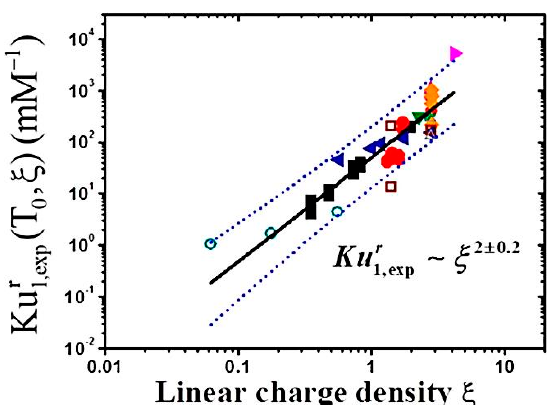
Figure 10. Experimentally reported binding strength data rescaled to SDS reference system as a function of polyelectrolyte reduced linear charge density. Solid black line is power-law regression and blue dotted line is 95% prediction interval. Points represent various studies. Reprinted with permission from Li, D.; Wagner, N.J. Universal binding behavior for ionic alkyl surfactants with oppositely charged polyelectrolytes. J. Am. Chem. Soc . 2013 , 135 , 17547–17555, doi:10.1021/ja408587u. Copyright 2013, American Chemical Society [98].